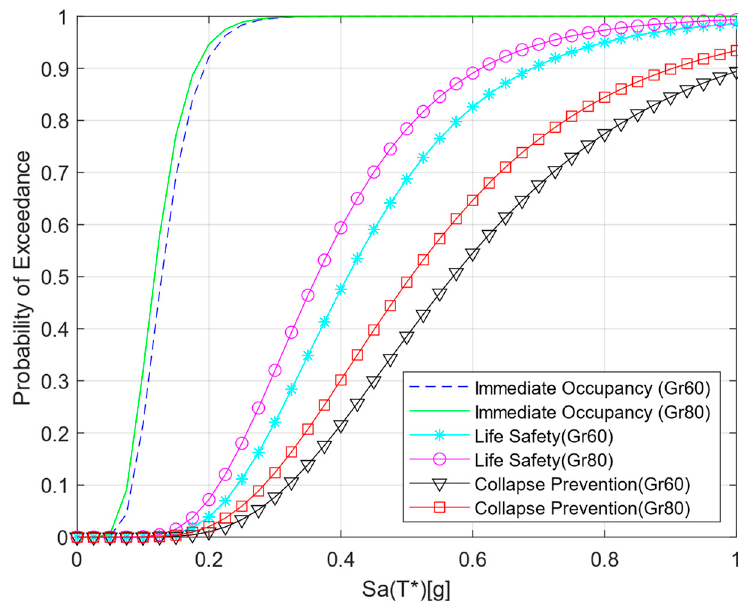
Figure 7. Fragility curves for the two buildings.